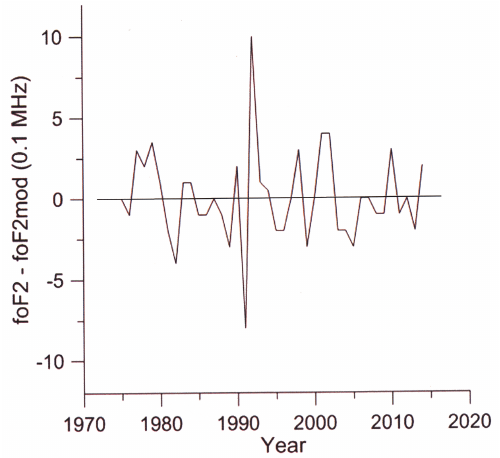
Figure 4. Residuals (cid:49) fo F2 (0.1MHz) after removal of solar activity (F10.7) influence (Eq. 1) separately for the three sub-periods 1975– 1990, 1990–2005, and 2005–2006, yearly values, for Chilton. Thin horizontal line – reference (zero)